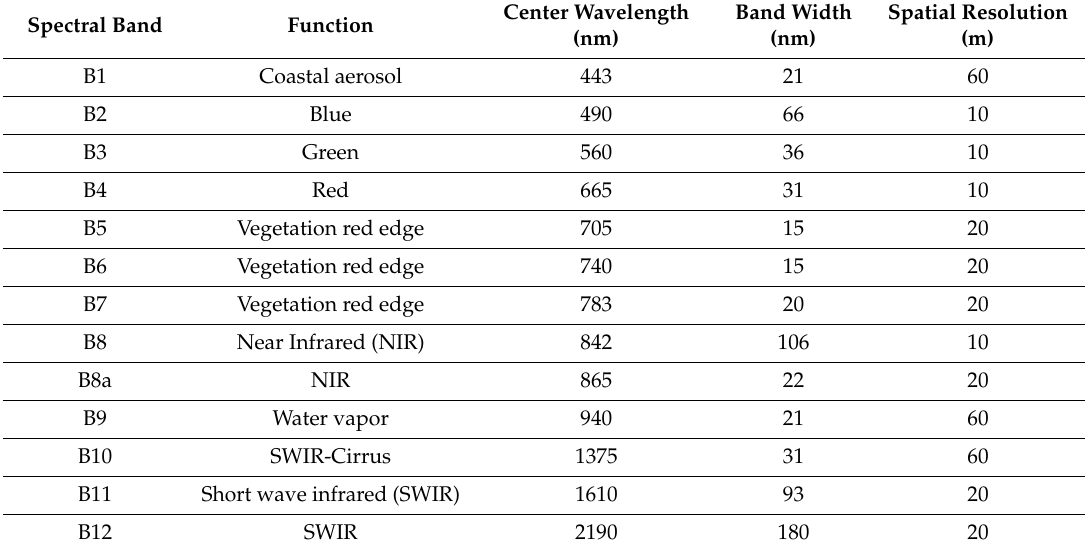
Table 2. Specifications of the Sentinel-2 multi-spectral instrument